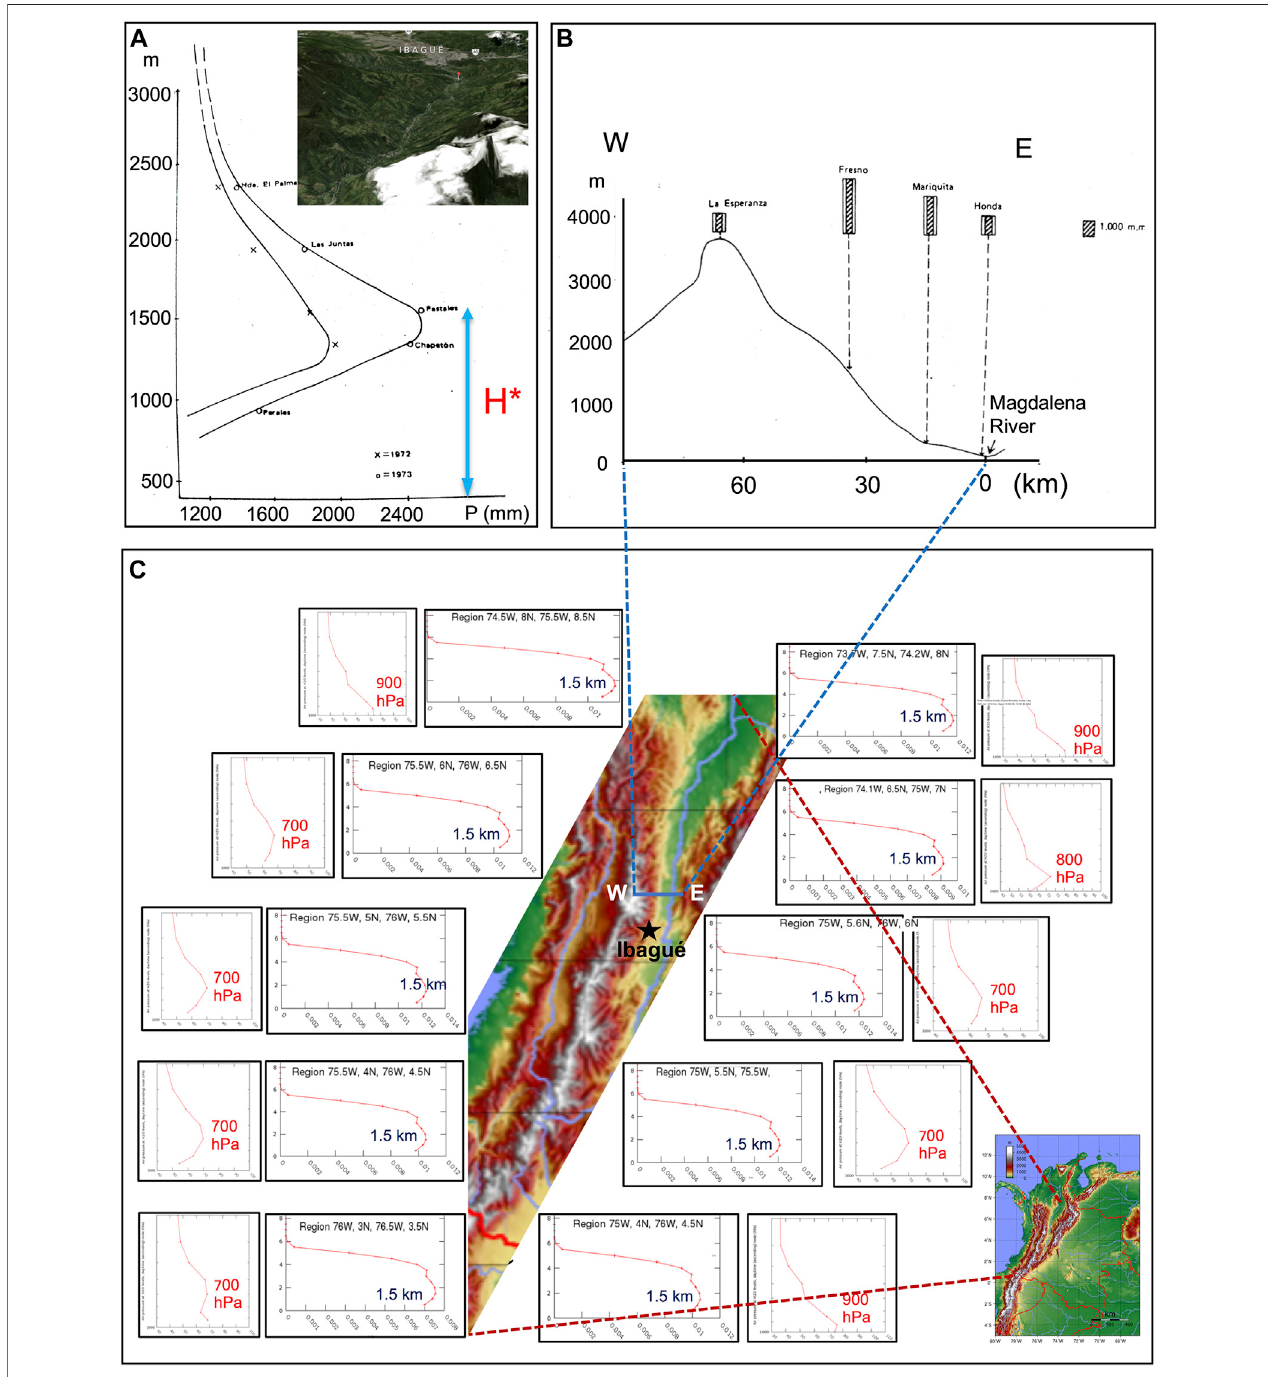
FIGURE2|(A) Distributionofrainfallwithelevation during1972and 1973alongthewesternslopeoftheintra-Andean valleyoftheCombeima Riverbasin,located alongtheeasternslopeoftheCentralrangeofColombianAndes.AdaptedfromOster(1979).TheinsetshowstheCombeimaRivervalleyandthecityofIbagué,denoted with a black star on panel (C) . Source: Google Maps. (B) Distribution of long-term mean annual rainfall with elevation and distance to the fl oor of the Magdalena River valley along the eastern slope of the Central Andes of Colombia around 5 ° N (W-E transect on panel (C) . Adapted from Oster (1979). (C) Vertical cross-sections of long-termmean TRMM rainfall data(3A12V7)and relativehumidity(AIRX3STM v006),alongdiverse transectsoverthe westernand eastern slopesoftheCentral Andes of Colombia. These fi gures were produced using the Giovanni online tool (https://giovanni.gsfc.nasa.gov/giovanni/).